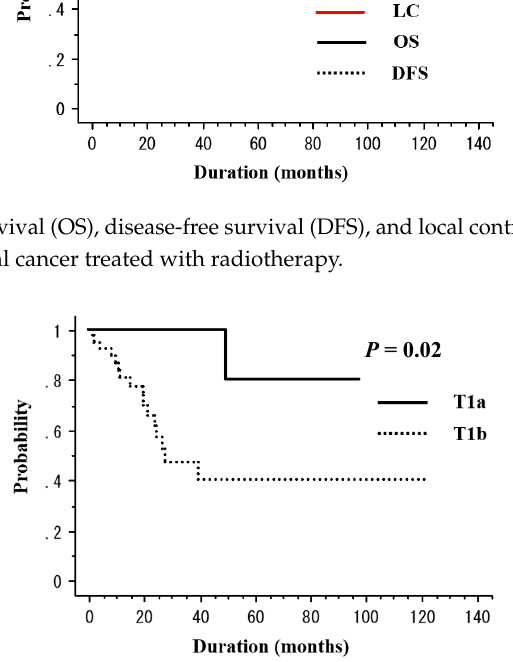
P = 0.067 P = 0.046